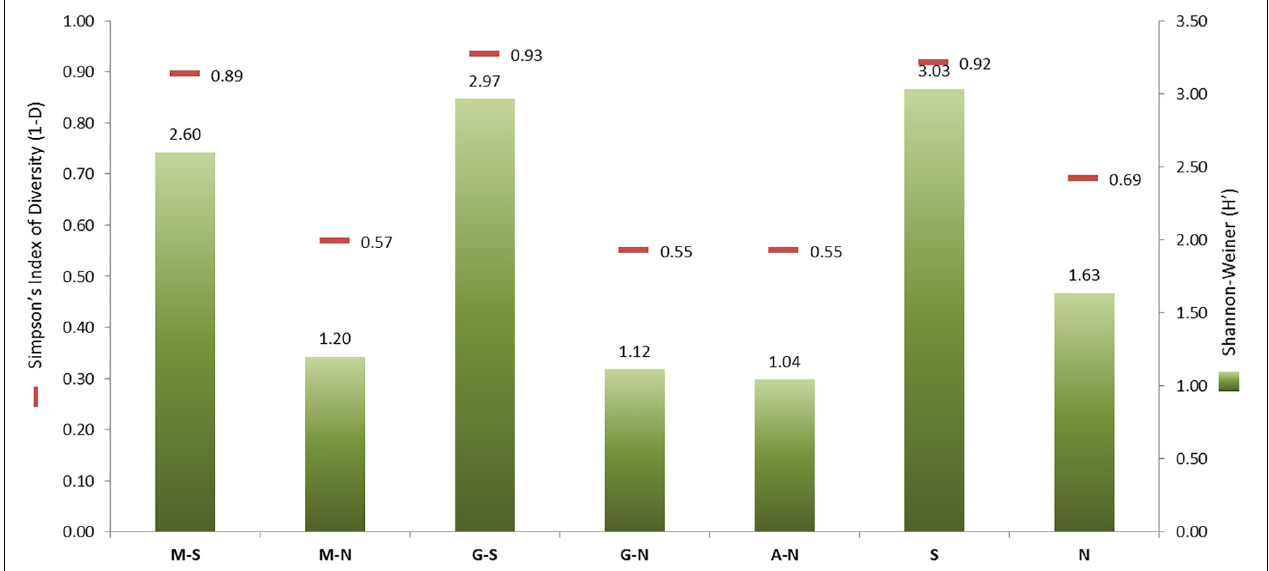
FIGURE 2 | Shannon–Weiner ( H (cid:48) ) and Simpson’s Indexes of Diversity (1– D ) generated after grouping the genotypes obtained by processing style [Spanish-style (S) and natural, directly brined olives (N)] or the combinations of them with the olive cultivar [Spanish-style Manzanilla, M-S; directly brined Manzanilla, M-N; Spanish-style Gordal, G-S; directly brined Gordal, G-N; and directly brined Aloreña, A-N]. The number of isolates in every group of samples was: M-S, 155; M-N, 104; G-S, 127; G-N, 118; A-N, 50; S, 282; N, 272. TABLE 1 | Technological characteristics in laboratory medium for the 16 predominant LAB genotypes obtained in the present study. NaCl resistance pH cardinal values